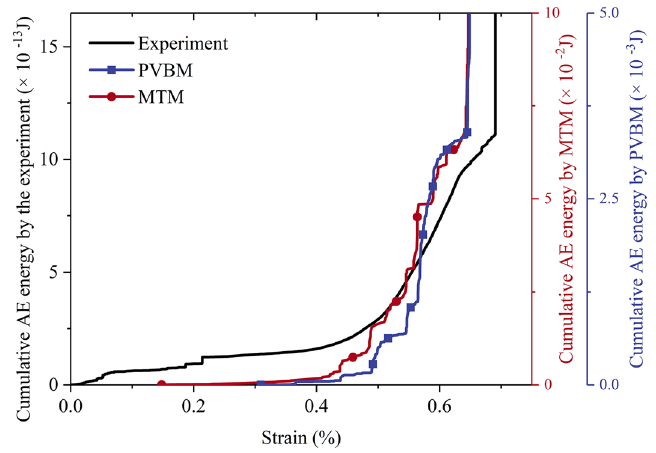
Figure 13. Comparison of cumulative energy by the experiment, PVBM and MTM.